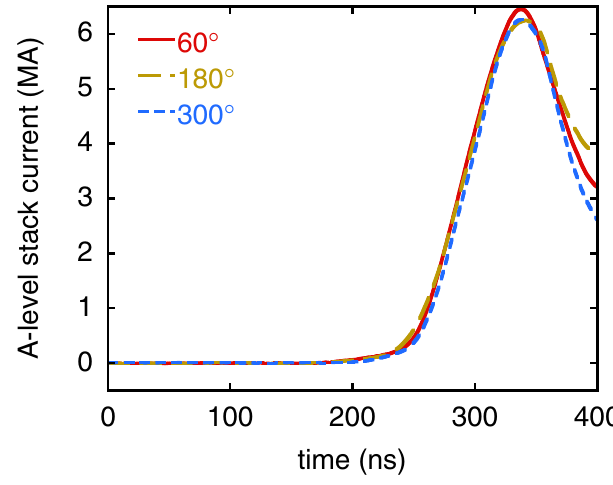
FIG. 13. (Color) Measurements on Z -shot 1548 of the A-level insulator-stack current at 3 azimuthal